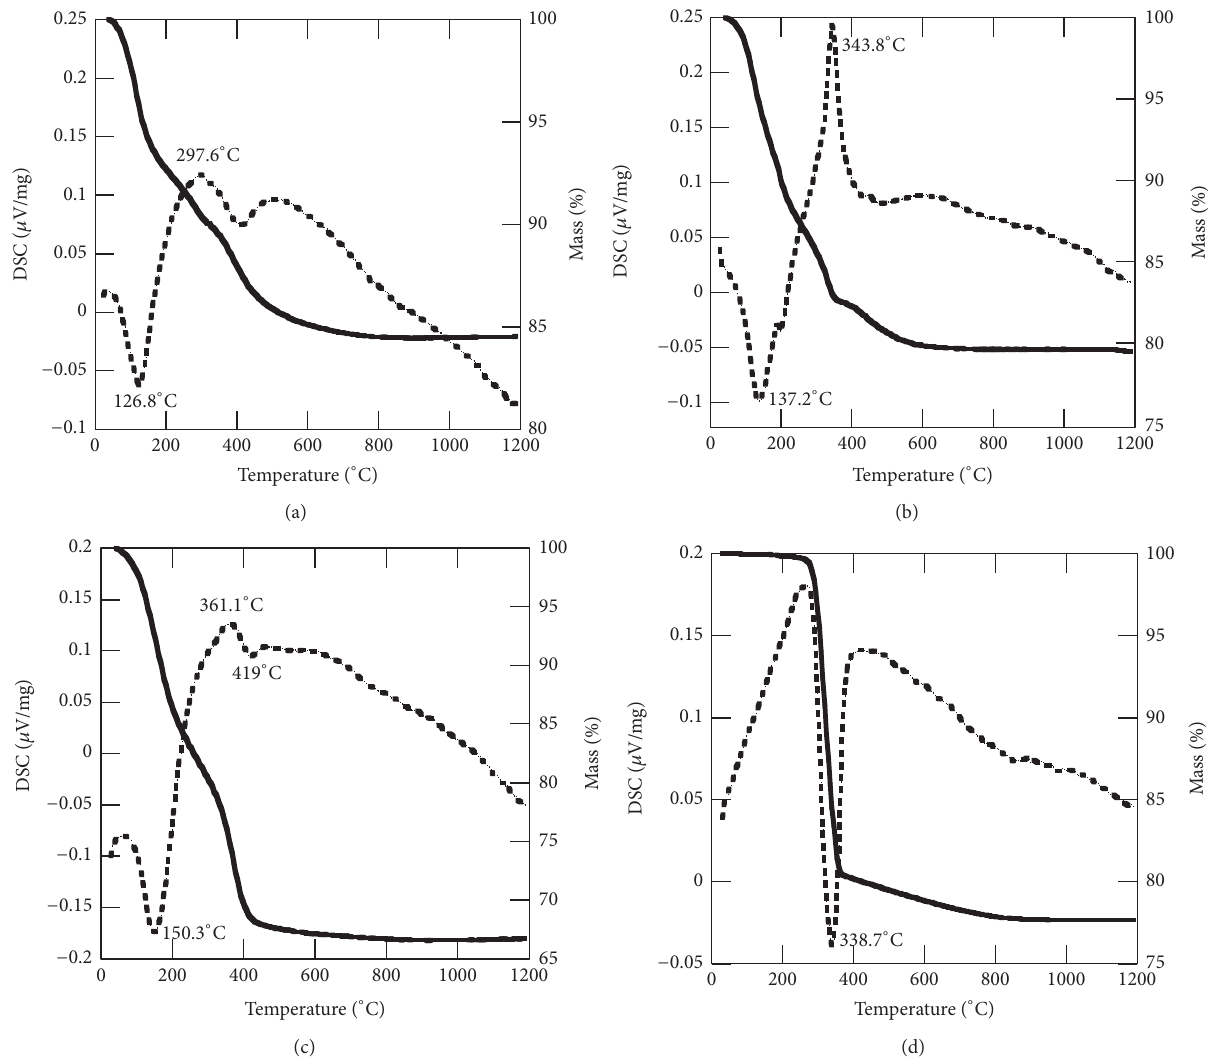
Figure 2: DSC (dashed lines) and TG (solid lines) thermographs of the as-synthesized powders: N-SDC20 (a), T-SDC20 (b), C-SDC20 (c), and U-SDC20 (d).